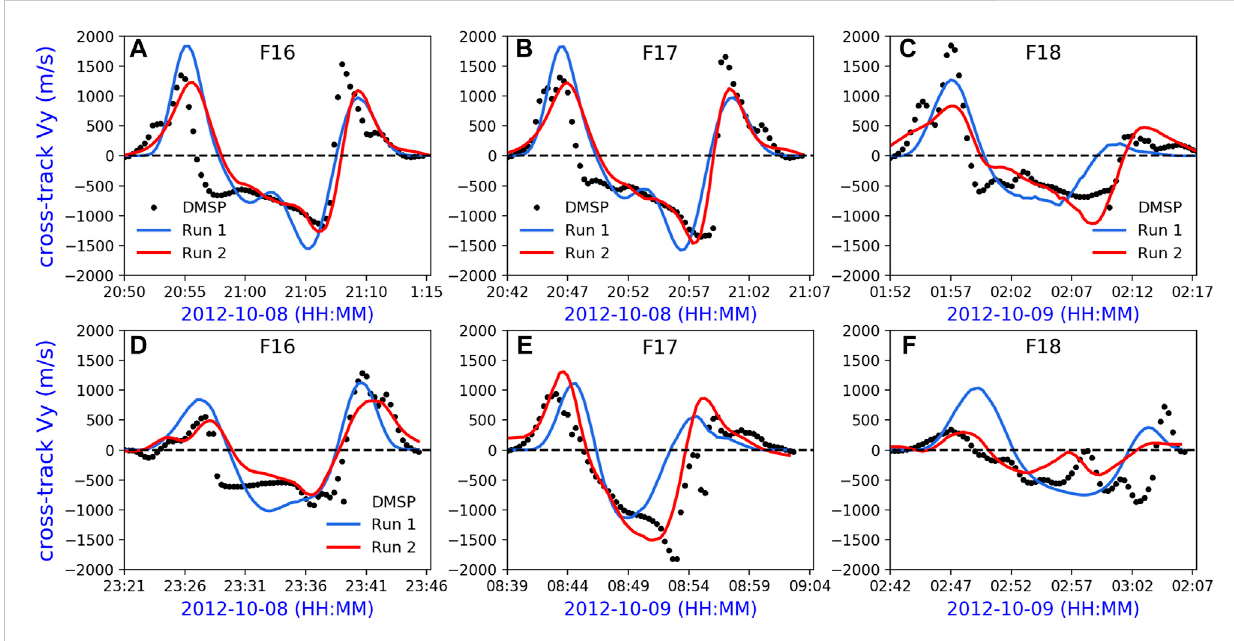
FIGURE 3 Comparison examples of the cross-track ion drift (V y ) along DMSP F16 (A,D) , F17 (B,C) , and F18 (C,F) trajectories. The black dots represent DMSP observations with a 13-point sliding window applied; blue and red lines represent GITM simulation run 1 and run 2, which are driven by empirical models and driven by data-based realistic patterns, respectively.